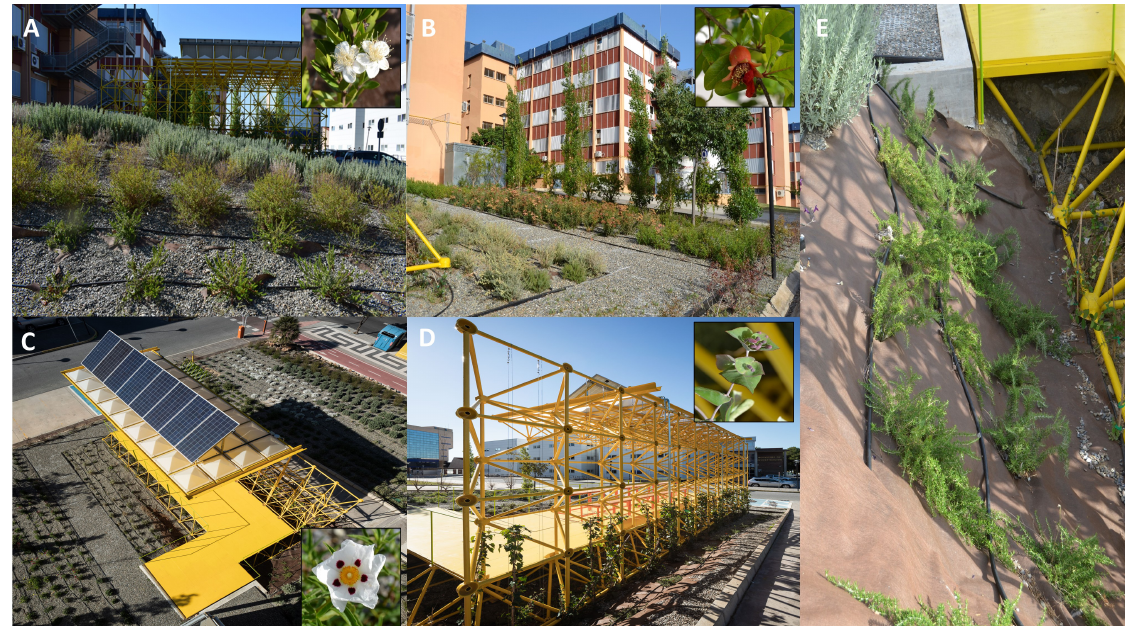
Figure 12. ( A ) Northern green wall constituted by the evergreen shrub Myrtus communis with a detail of the flower. ( B ) Southern green wall constituted by the combination of deciduous species Punica granatum and the tall tree Populus nigra with a detail of a fruit. ( C ) Bands showing some of the mediterranean-type xerophytic scrubs with a detail of a Cistus flower. ( D ) Northern green wall showing the vertical greened of the northern metallic tubular structure with Lonicera and Hedera species with a detail of flowering buds. ( E ) Prostrate scrubs of Rosmarinus officinalis var. postratus covering the bottom and ground part of the